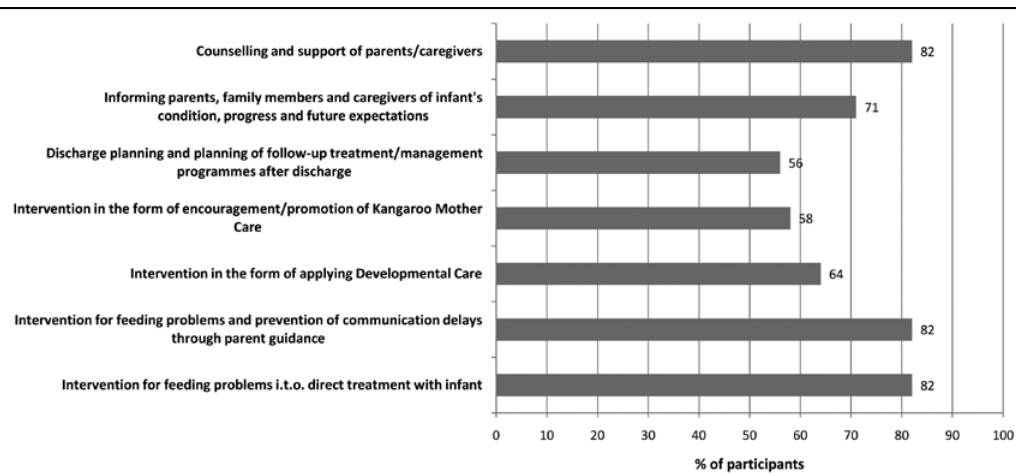
Fig. 1. Speech-language therapists’ indication of their roles regarding screening and assessment of the high-risk infant ( N